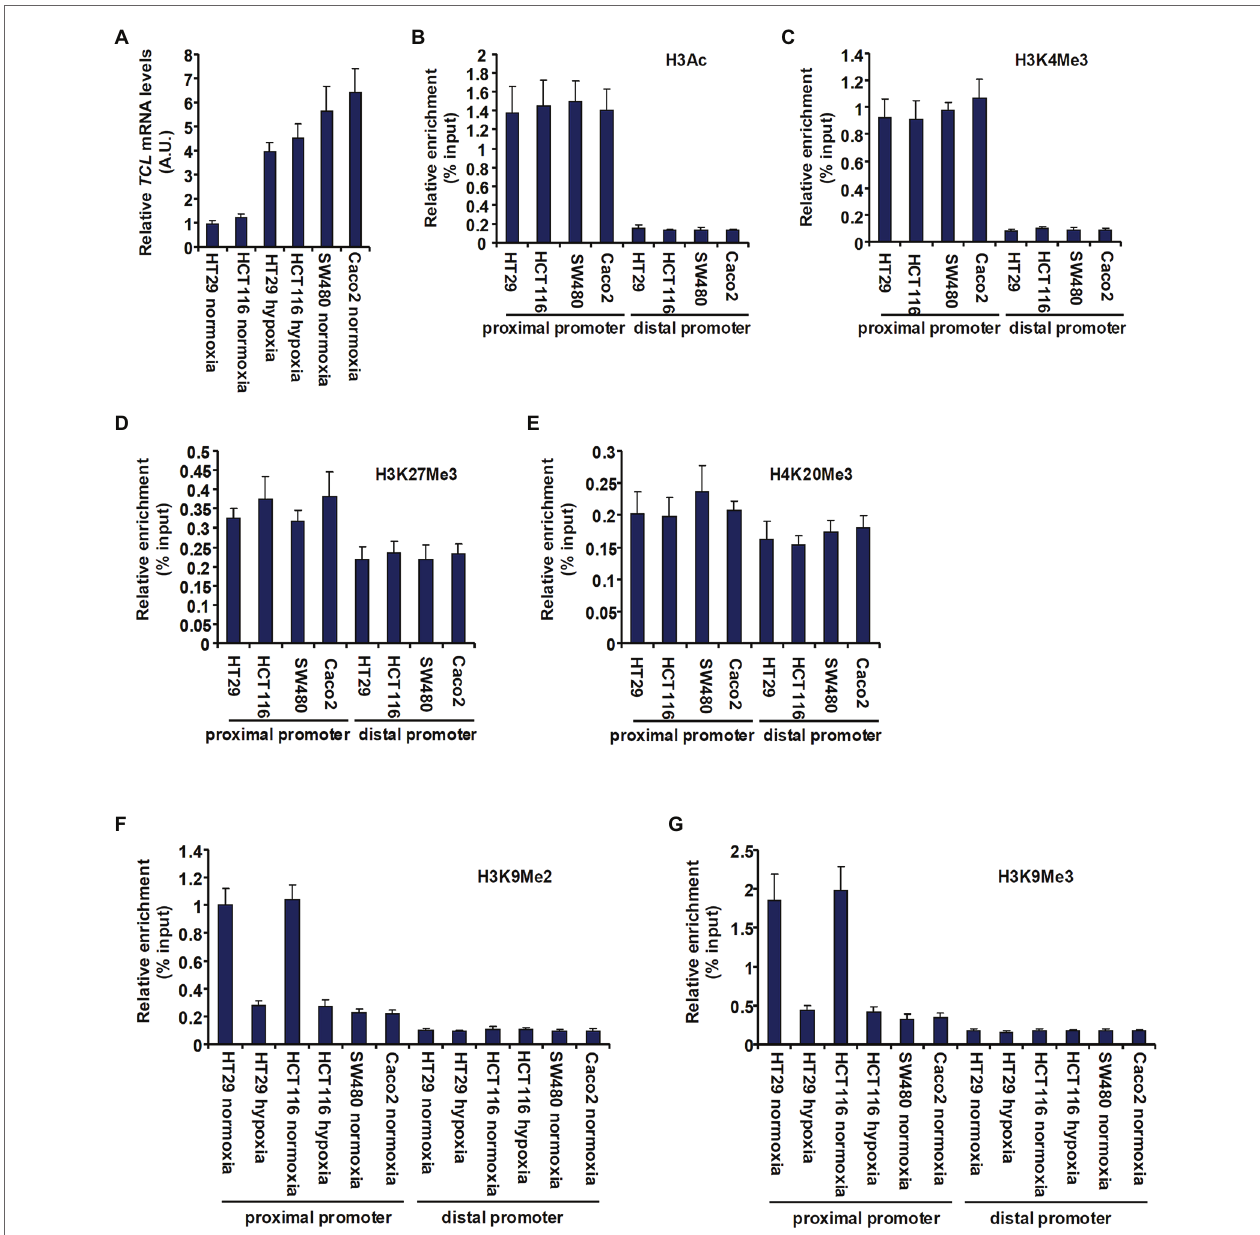
FIGURE 1 | Histone H3K9 methylation status determines differential TC10-like (TCL) expression in CRC cells. (A) colorectal cancer (CRC) cells were exposed to hypoxia or normoxia for 24 h. TCL expression levels were examined by qPCR. (B–E) Chromatin immunoprecipitation (ChIP) assays were performed with anti-pan- acetyl H3 (B) , anti-H3K4Me3 (C) , anti-H3K27Me3 (D) , and anti-H4K20Me3 (E) in CRC cells. (F,G) CRC cells were exposed to hypoxia or normoxia for 24 h. ChIP assays were performed with anti-H3K9Me2 (F) and anti-H3K9Me3 (G)